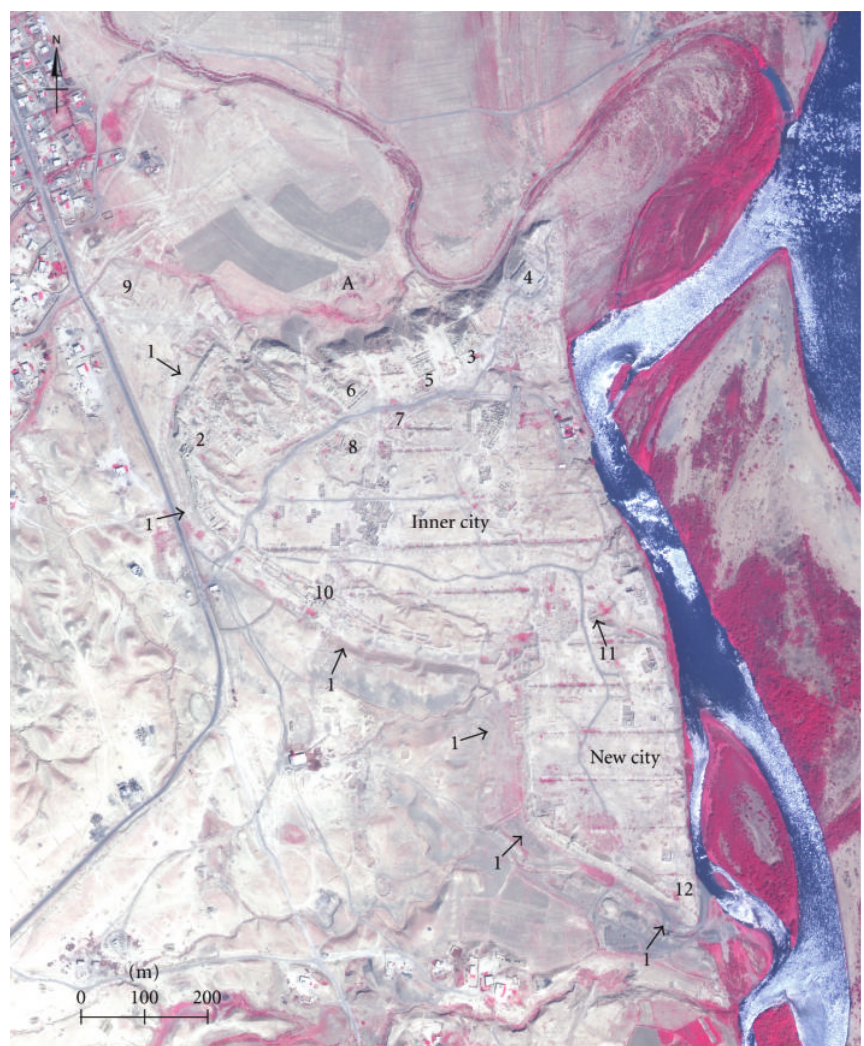
Figure 3: Ashur in a pan-sharpened (bands 4-3-2) QuikBird-2 image taken in 2005: (A) ancient river course of the Tigris; (1) moat outside the city walls; (2) Tabira Gate; (3) Ziggurat; (4) Temple of Ashur; (5) Old Palace and Palace of Adad-nirari I; (6) Temple of Anu and Adad; (7) Temple of Sin and Shamash; (8) Temples of Ishtar and of Nabu; (9) Akitu Temple; (10) West Gate; (11) South Gate of the inner walls; (12) South Gate of the outer